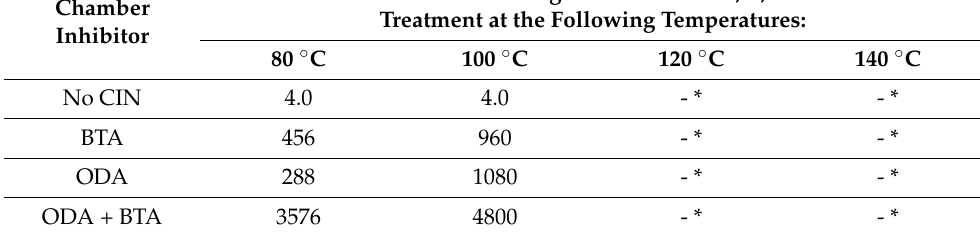
Table 1. Protective aftereffect (PAE) of adsorption films formed upon treatment of copper in CIN vapors at different t measured in a heat and moisture chamber. τ CT = 60